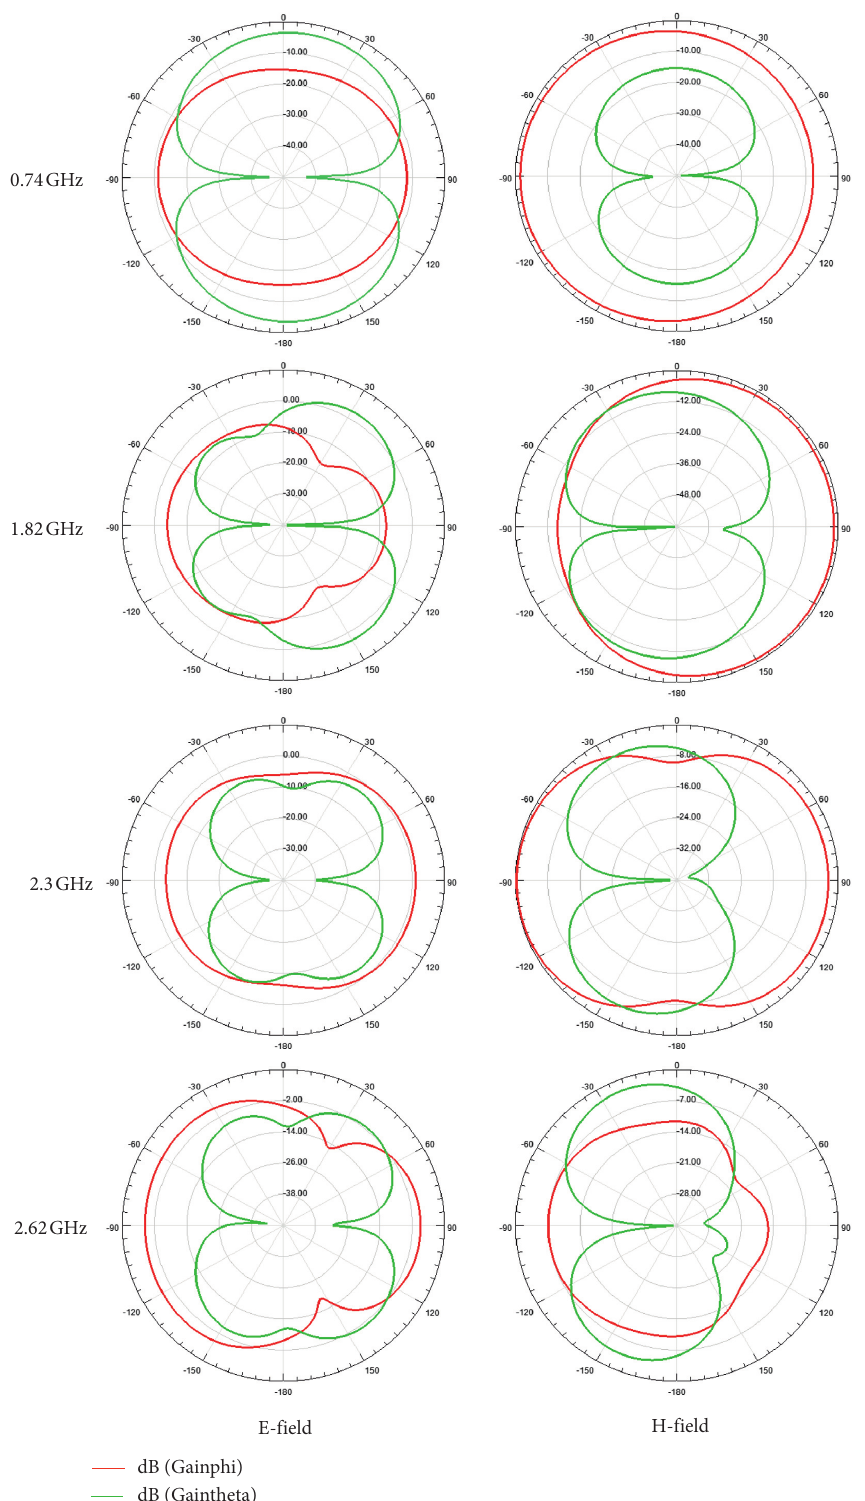
Figure 7: Field pattern of the